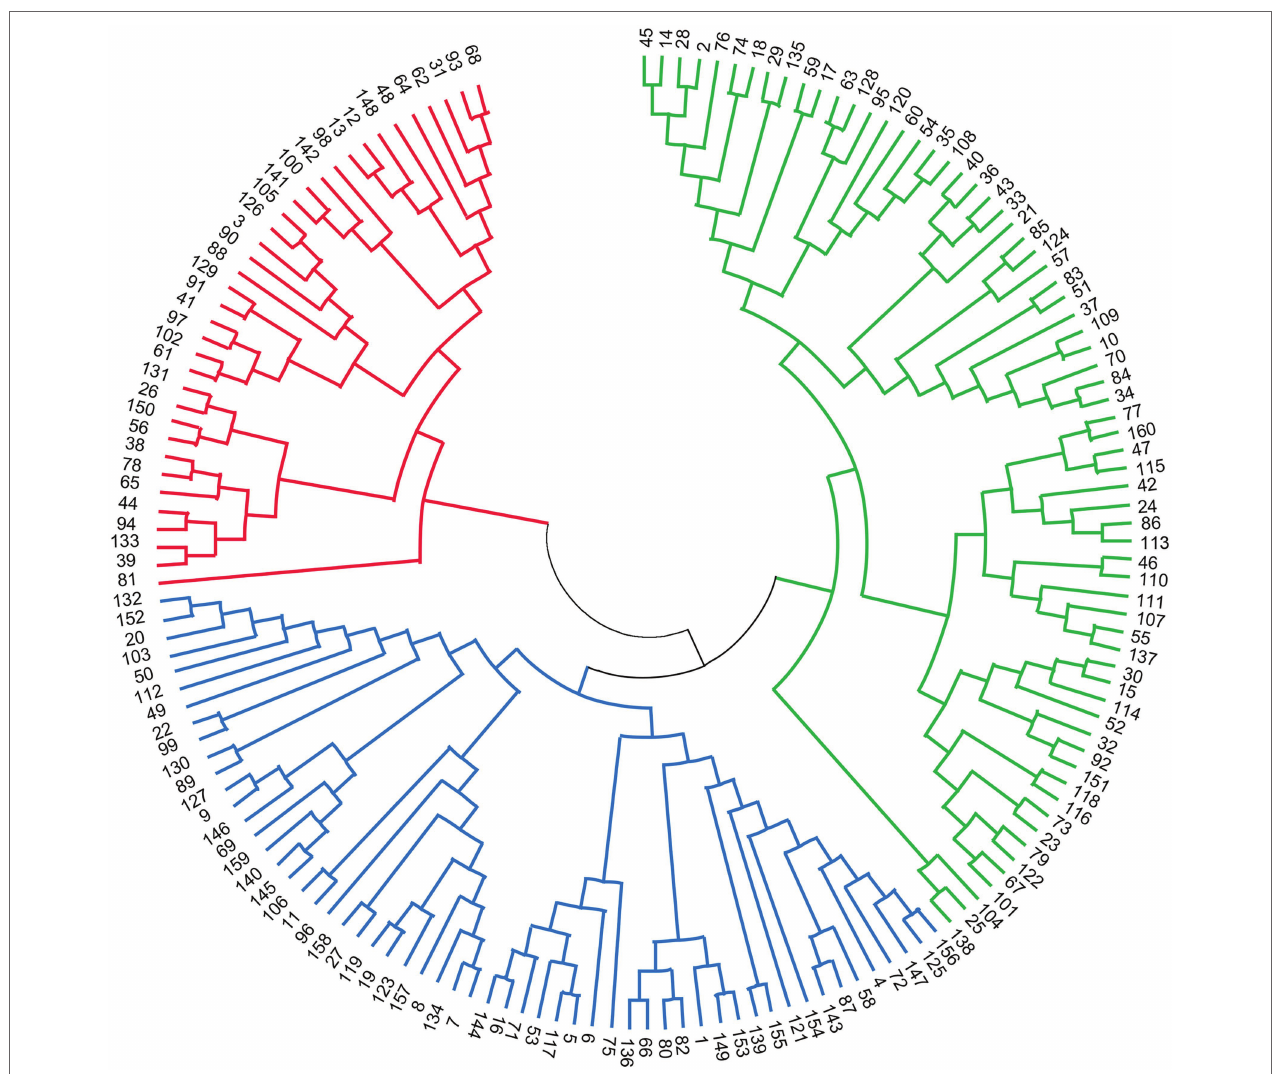
FIGURE 2 | The Neighbor-Joining (NJ) tree of 160 accessions based on the data of 38